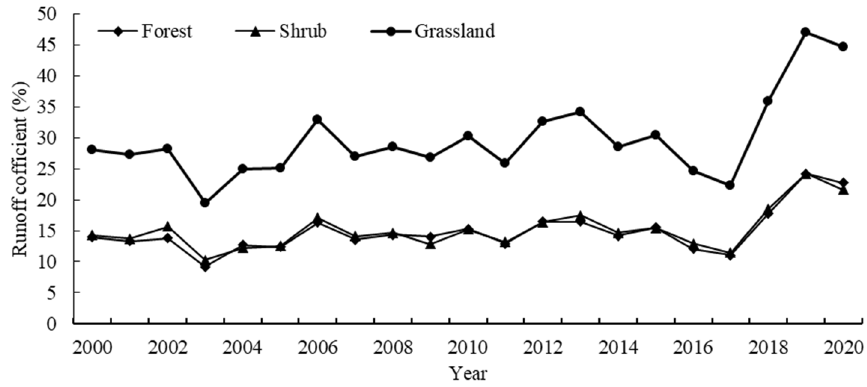
Figure 13. Interannual variation in runo ff coe ffi cient of forest, shrub and grassland.